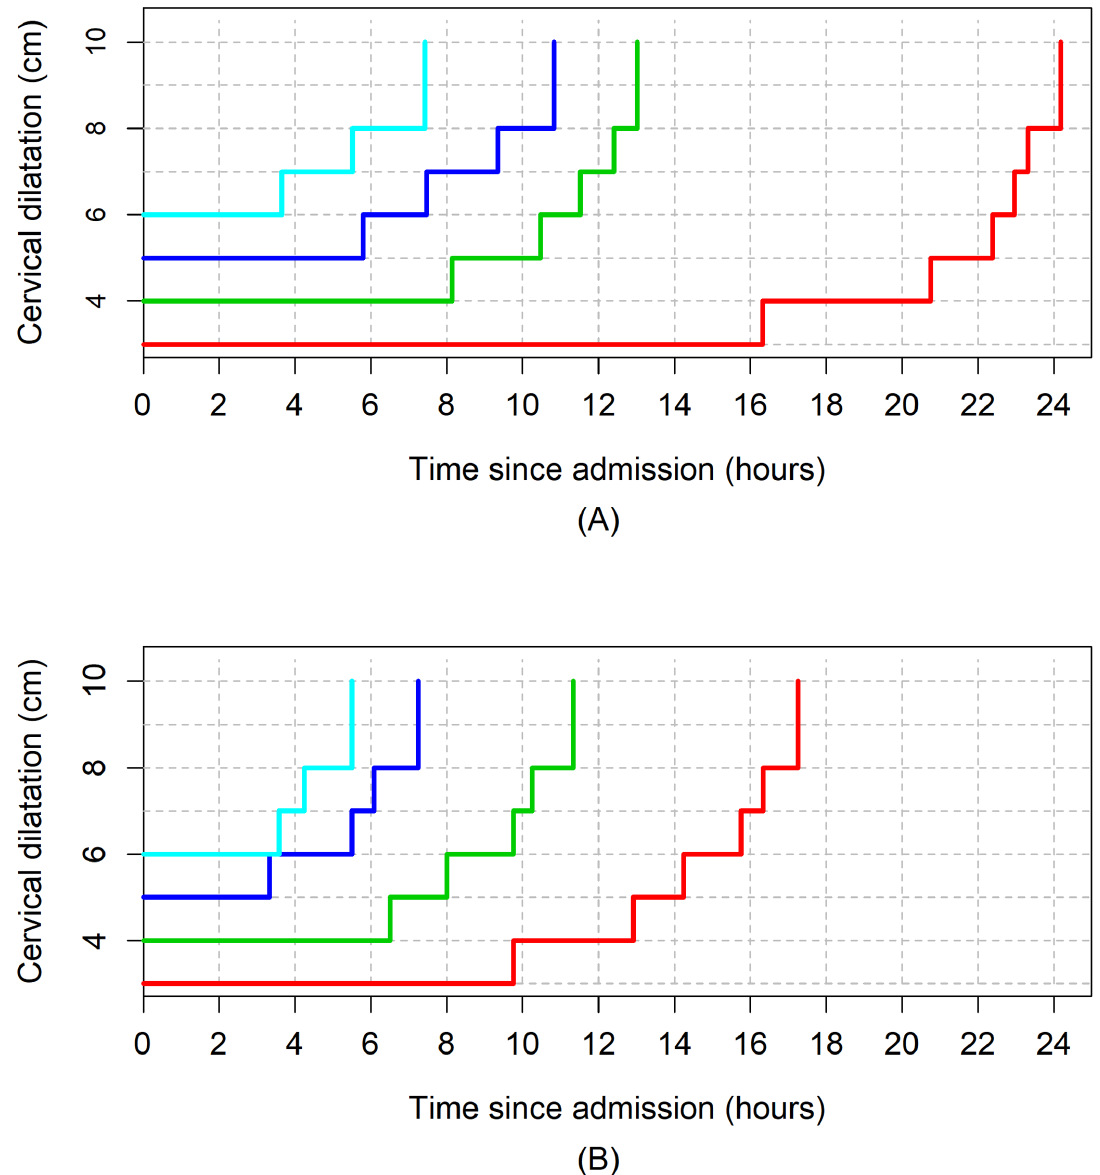
Fig 5. The 95th percentiles of cumulative duration of labour among parity = 2+ women. (A) Survival analysis. (B) Multistate Markov analysis.